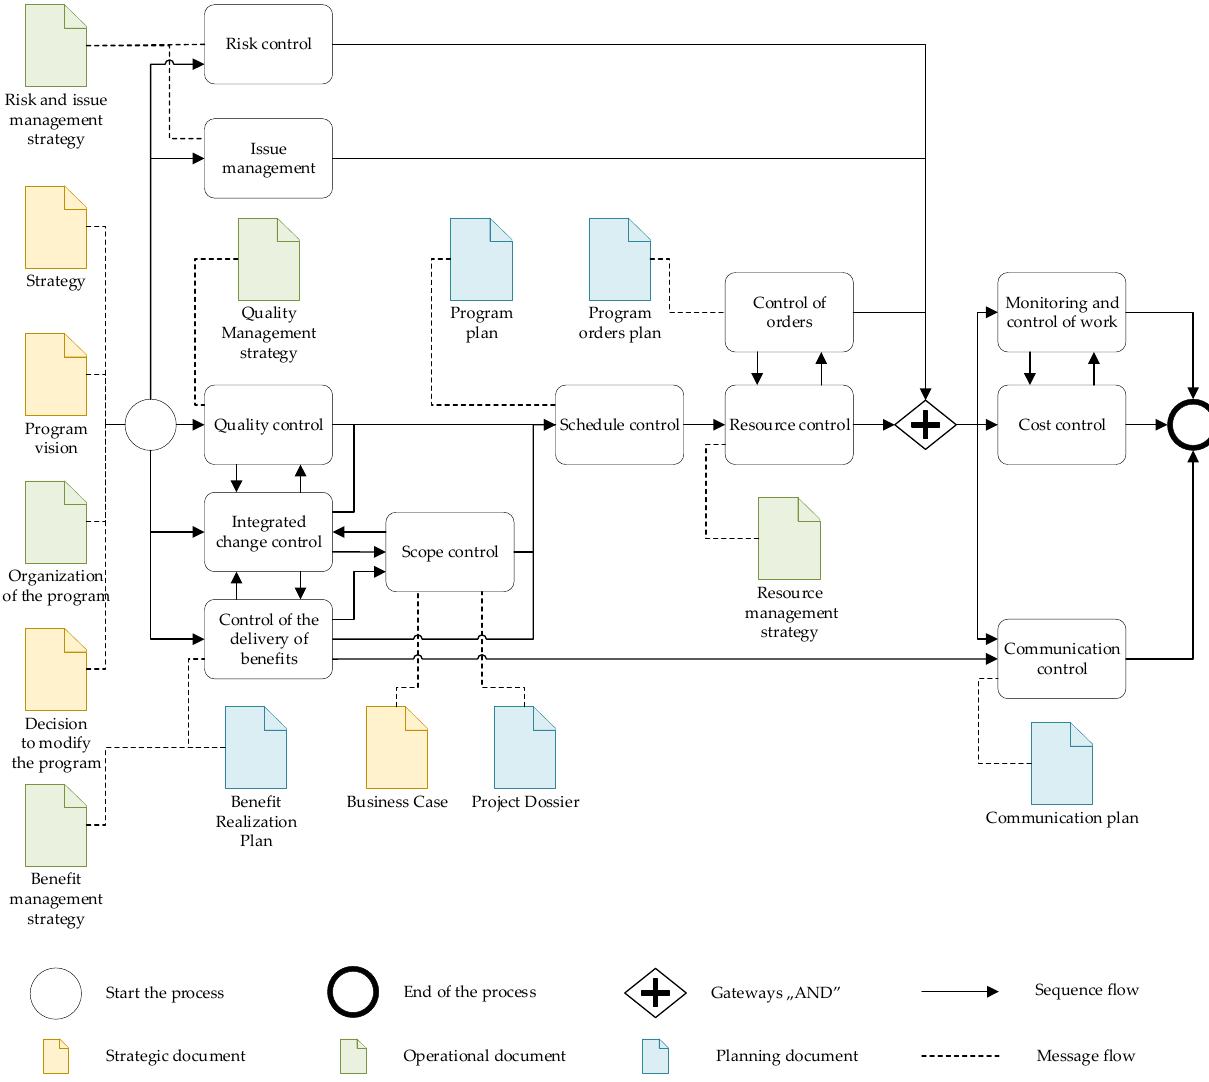
Figure 14. Programme monitoring and control process—concept. Source: own elab.